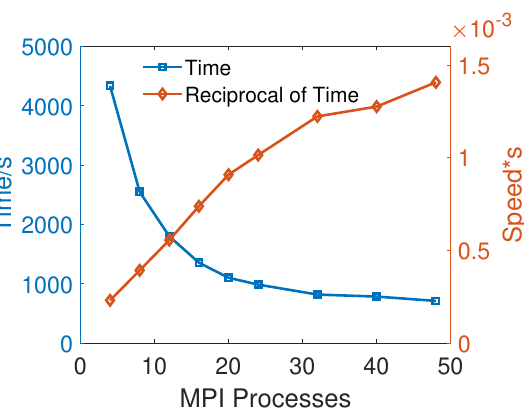
Figure 6. Times used to run simulations with a 256 2 grid for 145600 time steps on a workstation with dual CPUs (two Intel Xeon Platinum 8280 CPUs) and shared memory. The “speed” is defined as the reciprocal of the time